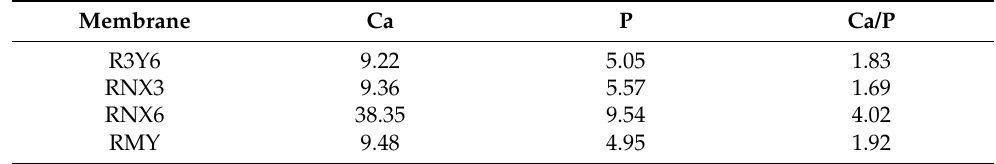
Figure 6. SEM images at 500 × magnification of the membranes ( a ) RNX3, ( b ) RMY, ( c ) R3Y6, ( d ) R2Y4, and ( e ) RNX6 after 6 days of immersion in SBF. Table 4. Ratio of Ca/P present in the membranes submerged for 6 days in